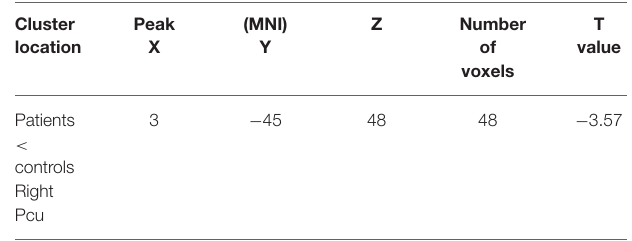
TABLE 2 | Signification differences in NH values between the